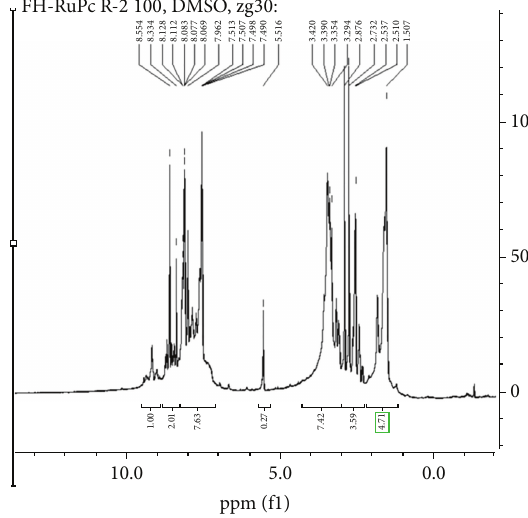
Figure 4: 1 H NMR spectrum of C 3 R 󸀠󸀠 RuPc